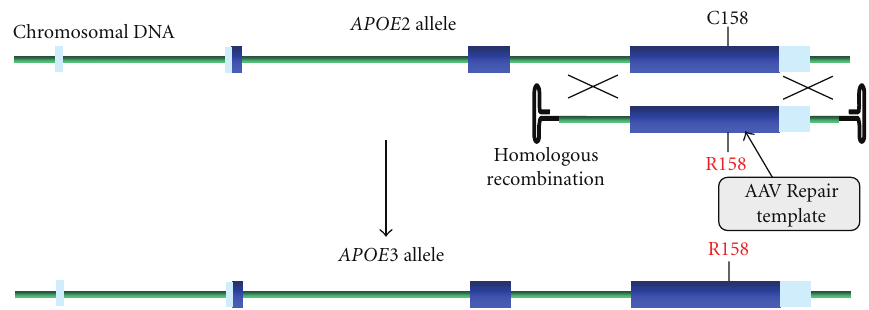
Figure 4: Conversion of the mutant APOE2 allele to wild-type APOE3 using an AAV-based DNA repair sequence. The single-stranded adeno-associated virus genome, which contains Exon 4 of APOE3 and its flanking regions within its ITRs (inverted terminal repeats), is an e ffi cient recombination template. As indicated, the mechanism is via a homologous recombination (HR)